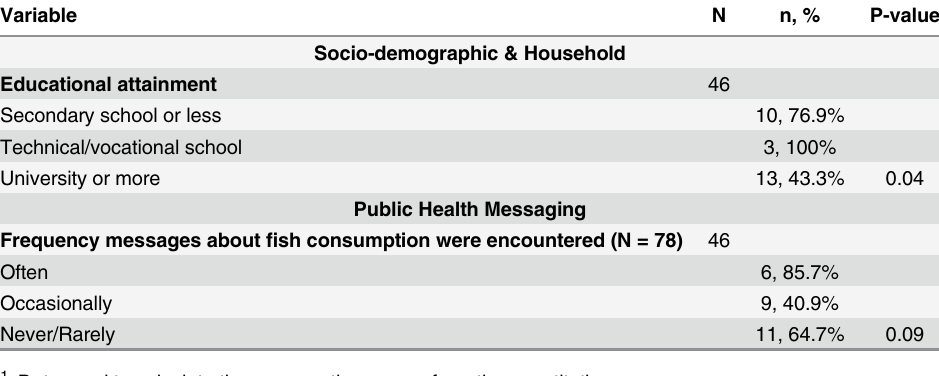
Table 4. Characteristics associated with reduced consumption of small fish species during preg- nancy, among those women who eat small fish 1,2